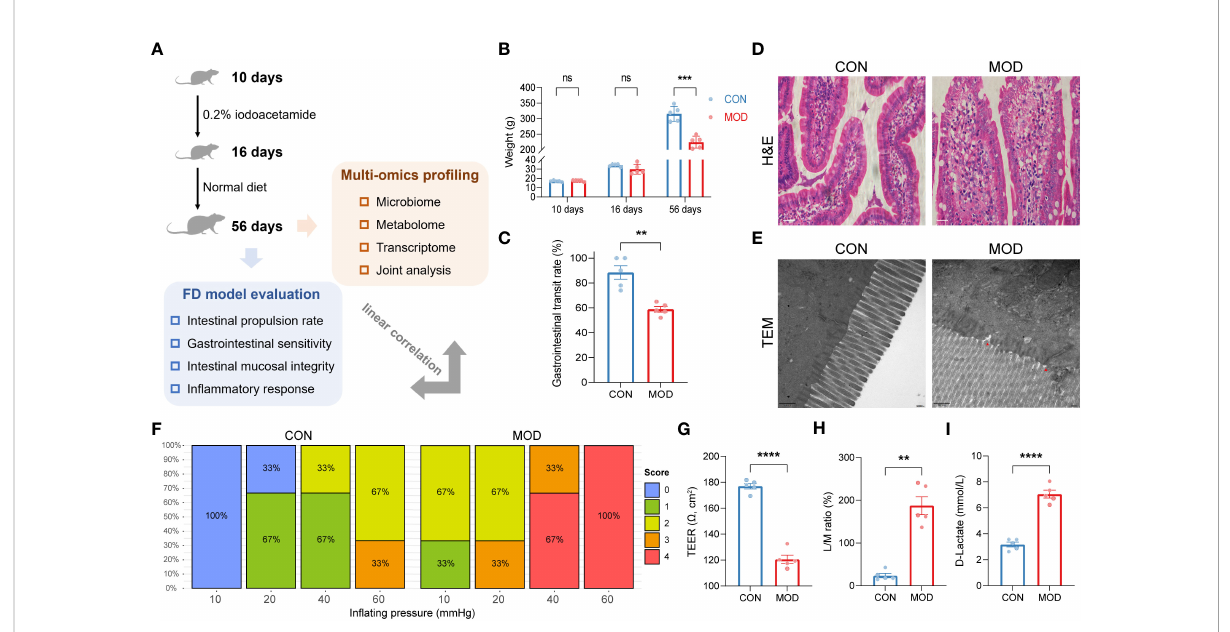
FIGURE 1 Phenotypes found in the rat model of FD. (A) A schematic diagram of the multi-omics analysis. (B) Changes in body weights (*** p < 0.001 by two-way ANOVA with correction of two-stage linear step-up procedure of Benjamini, Krieger and Yekutieli, ns indicates not signi fi cant). (C) Gastrointestinal transit rate. (D) H&E-stained duodenum. Scale bar, 20 m m. (E) TEM analysis of duodenum. Scale bar, 500 nm. Two red triangles indicate incomplete tight junctions. (F) Behavioral testing of GD (10 to 60 mmHg) and pain score (0-4). (G) TEER of duodenal epithelial barrier (**** p < 0.0001 by unpaired t test with Welch ’ s correction). (H) Urine L/M ratio (** p < 0.01 by Mann Whitney test). (I) Plasma content of D-lactate (**** p < 0.0001 by unpaired t test with Welch ’ s correction). The circles on the bar plots represent individual values with mean ± SEM (bars) ( n = 3 or 5